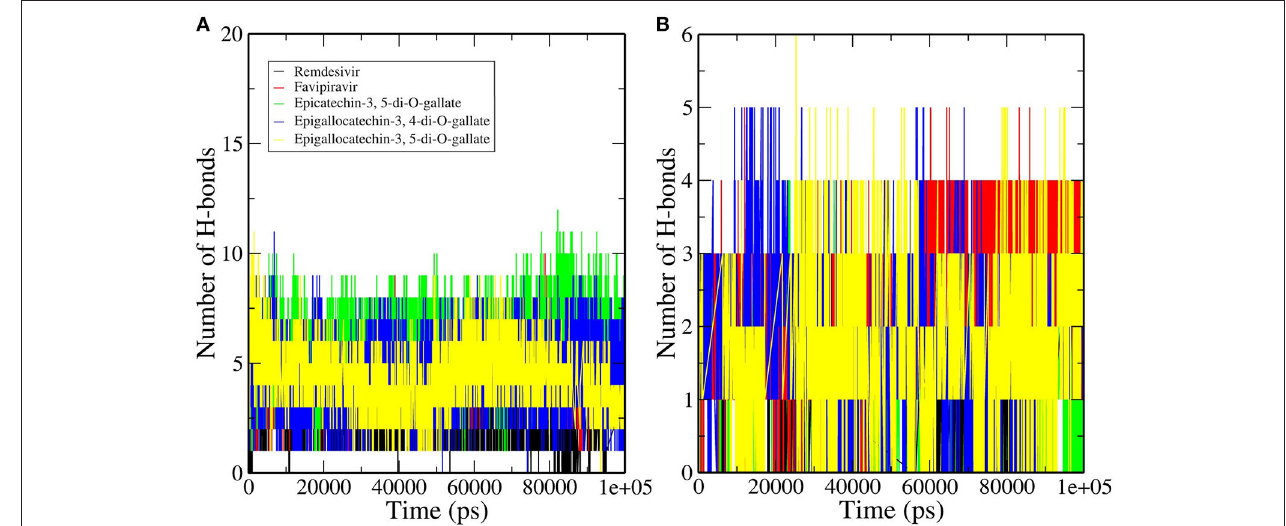
FIGURE 5 | Hydrogen bond profiles of the RNA–RdRp complex of SARS-CoV-2 having (A) RdRp and (B) RNA.